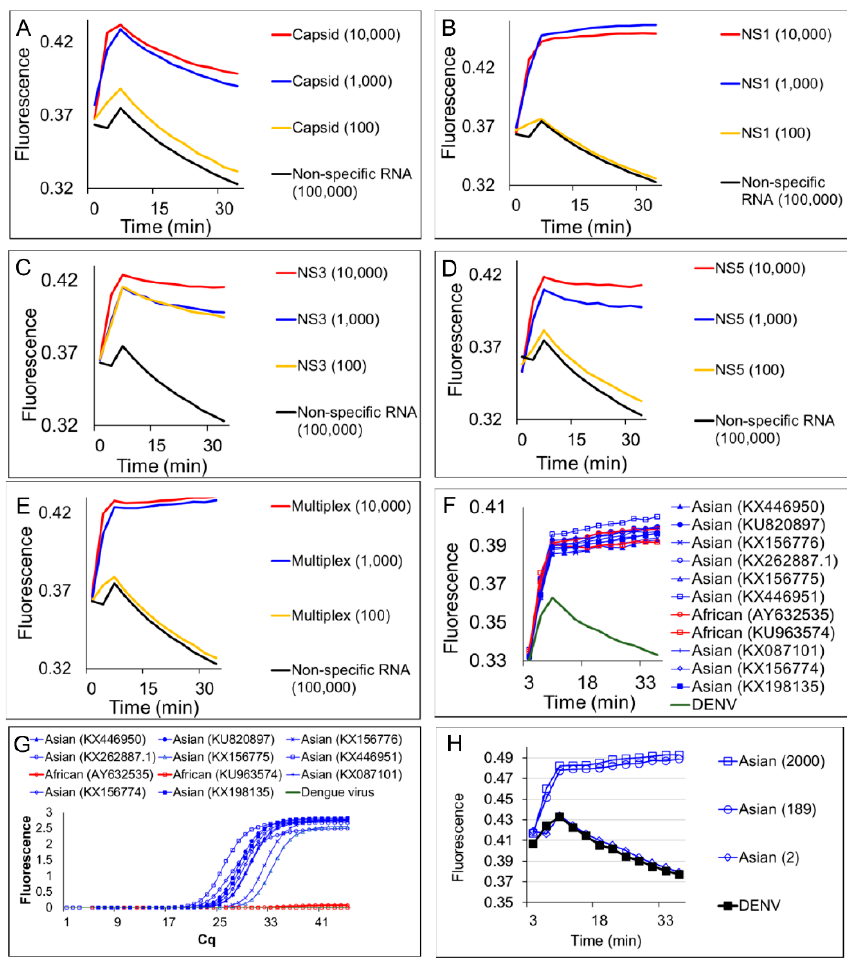
Figure 5. Simultaneous detection of four Zika virus genes using degenerate 4GO probes and multiplex degenerate reverse transcription LAMP (multiplex LAMP-4GO) assays. Indicated copies of capsid , NS1 , NS3 , and NS5 synthetic target RNA were amplified either individually (panels A – D , respectively) or as a mixture (panel E ) using multiplex LAMP-4GO assays containing LAMP primers for all four ZIKV targets and the four-input 4GO probe. 4GO probe fluorescence, measured in real-time at 37 ◦ C after 90 min of LAMP amplification, is depicted as red (10,000 template copies), blue (1,000 template copies), yellow (100 template copies), and black (non-specific LAMP primers with 10 5 copies of its target RNA) traces. The x -axis depicts the duration of endpoint signal measurement. ( F ) Detection of Asian and African lineage ZIKV genomic RNA using degenerate multiplex LAMP-4GO assays. Genomic RNA from DENV, or Asian or African lineage ZIKV (indicated by their GenBank accession numbers) were used as templates for amplification. 4GO probe fluorescence, measured in real-time at 37 ◦ C after 90 min of LAMP amplification, is depicted as blue (Asian), red (African), and green (DENV) traces. The x-axis depicts the duration of endpoint signal measurement. ( G ) Detection of Asian and African lineage ZIKV genomic RNA using TaqMan qRT-PCR assay specific for Asian lineage ZIKV NS2b gene. Same amount of viral genomic RNA as was used in panel F were amplified and real-time measurements of assay fluorescence are depicted as blue (Asian), red (African), and green (DENV) traces. ( H ) Detection limit of degenerate multiplex LAMP-4GO assay for ZIKV genomic RNA. Indicated copies of an Asian lineage ZIKV genome or non-specific DENV genomes were amplified using multiplex LAMP-4GO assays. 4GO probe fluorescence, measured in real-time at 37 ◦ C after 90 min of LAMP amplification, is depicted as blue (Asian) and black (DENV) traces with template copies indicated by open squares (2000 genomes), open circles (189 genomes), and open diamonds (2 genomes). The x -axis depicts the duration of endpoint signal measurement. For all experiments, representative results from three replicate tests are